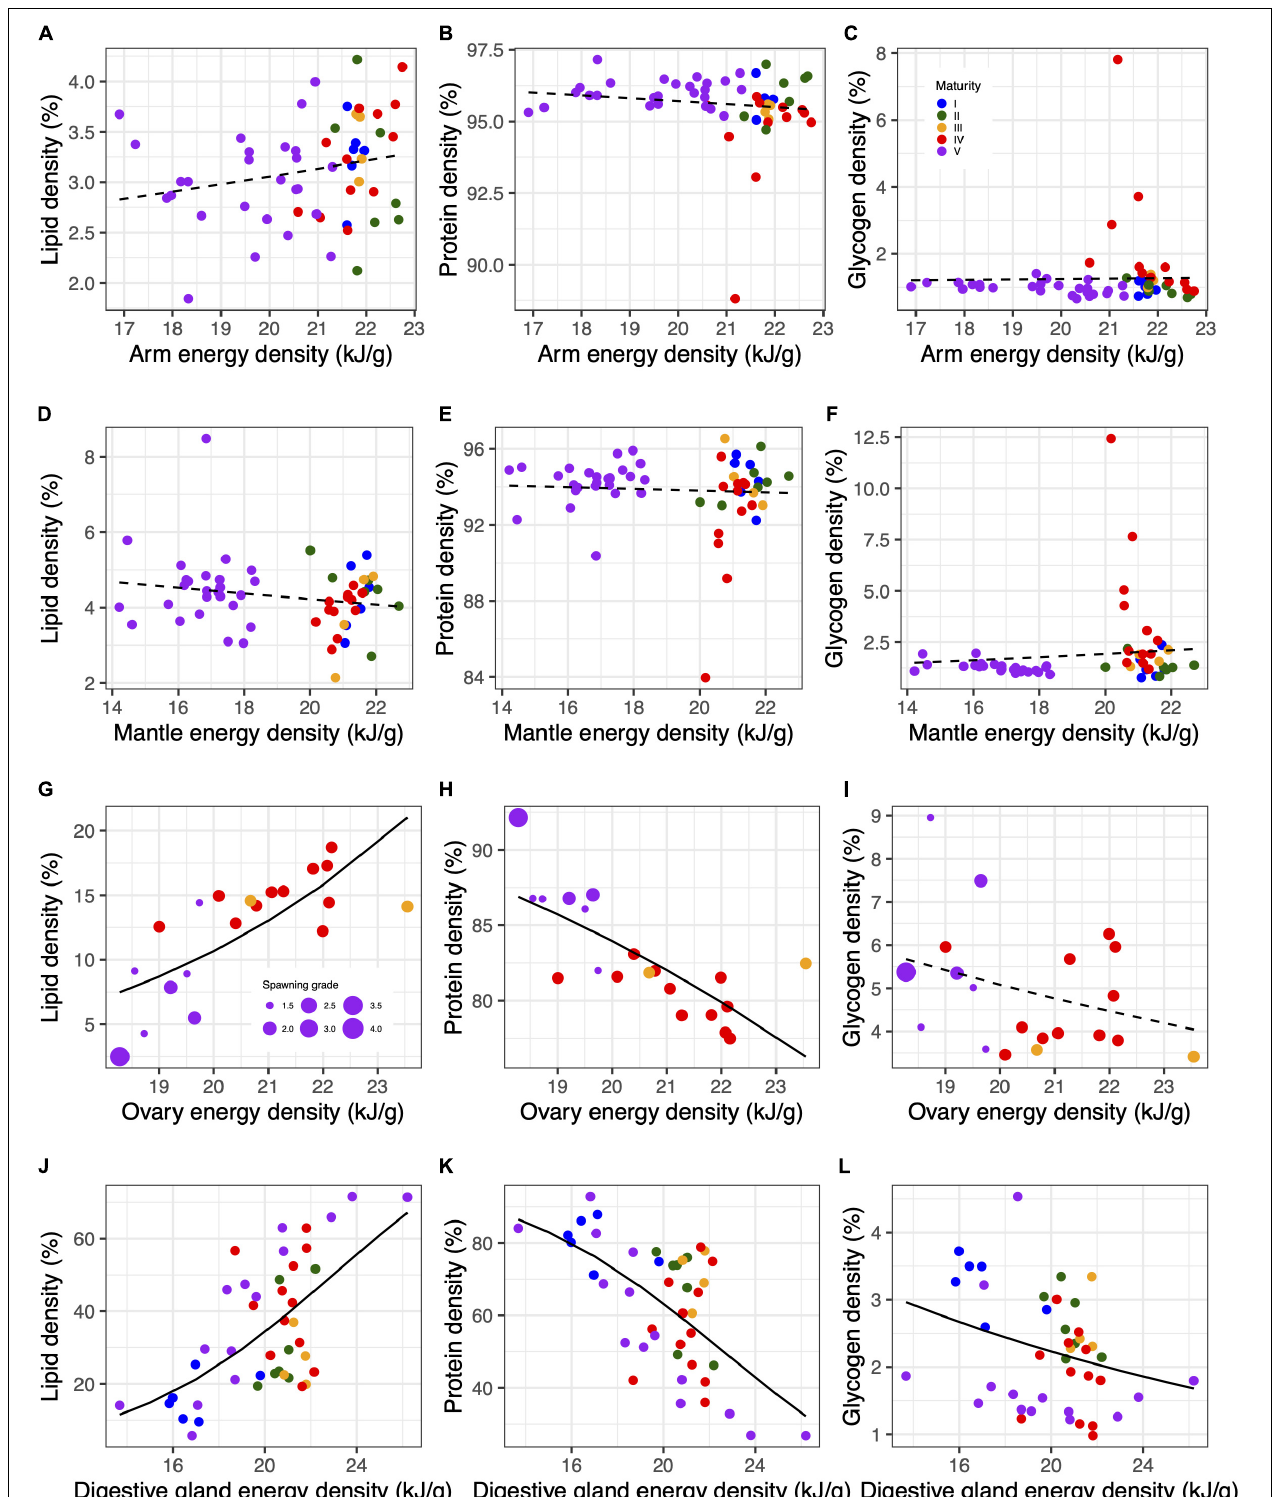
FIGURE 9 | Relationships between constituent (lipid, protein and glycogen) density and energy in the arm (A–C) , mantle (D–F) , ovary (G–I) and digestive gland (J–L) . Dots are colored by maturity macrostage and spawning, and post-spawning individuals are scaled according to spawning grade. Lines show beta regression fits with solid lines indicating that the slope is statistically significant ( p < 0.05). See Supplementary Figure 13 for a plot excluding glycogen from the density calculation. See Supplementary Table 3 for numerical results.